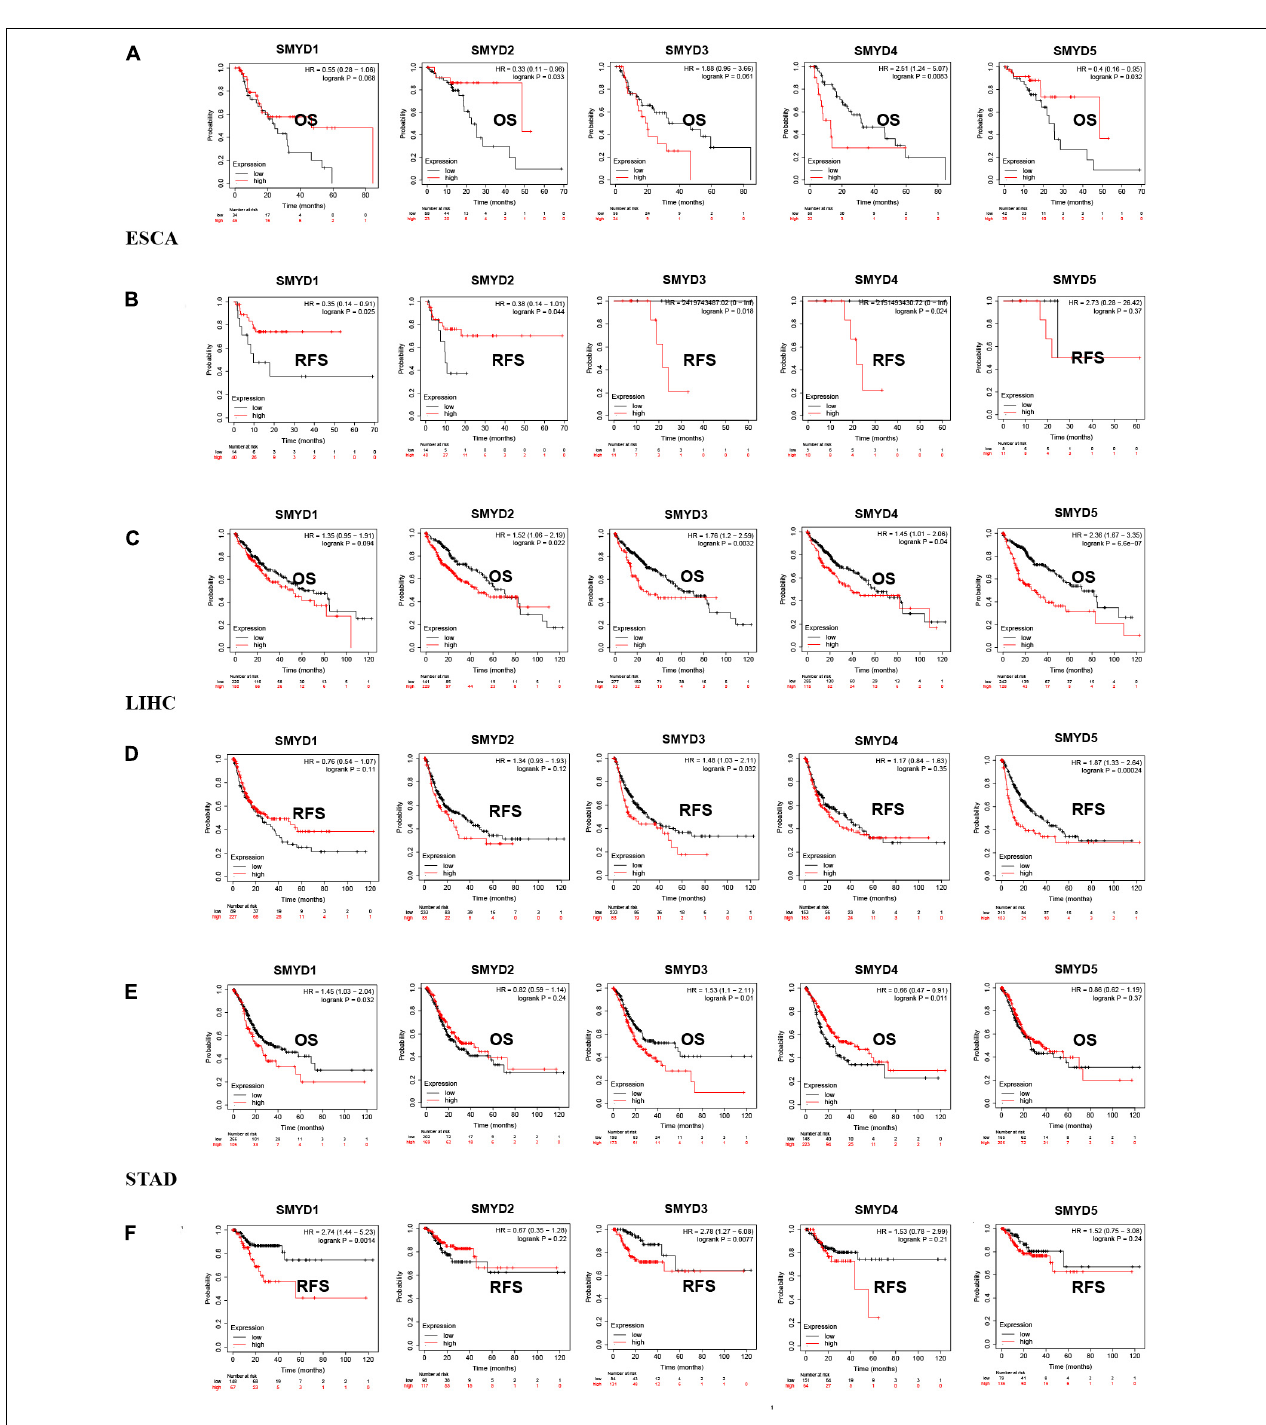
FIGURE 4 | The prognostic value of mRNA expression levels of SMYD family members in ESCA, LIHC, and STAD patients (Kaplan–Meier plotter). Plot the relationship between high expression (red) and low expression (black) of target gene mRNA and OS and RFS, respectively (A–F) ( P < 0.05 with statistical